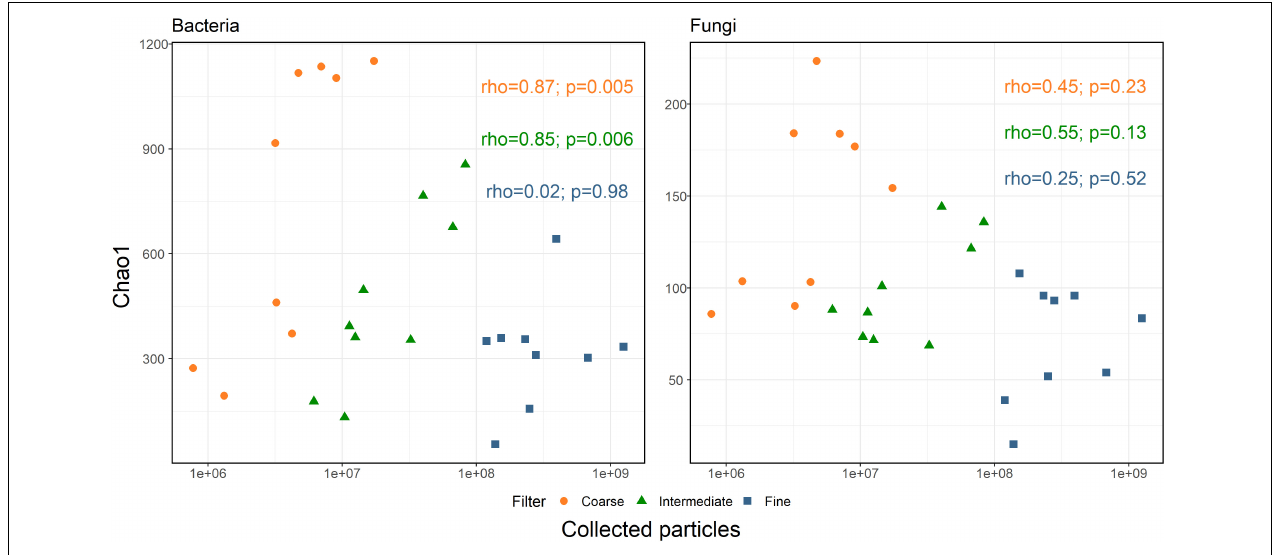
FIGURE 4 | Spearman’s correlation between Chao1 diversity indices and the number of sampled particles per size-class, per